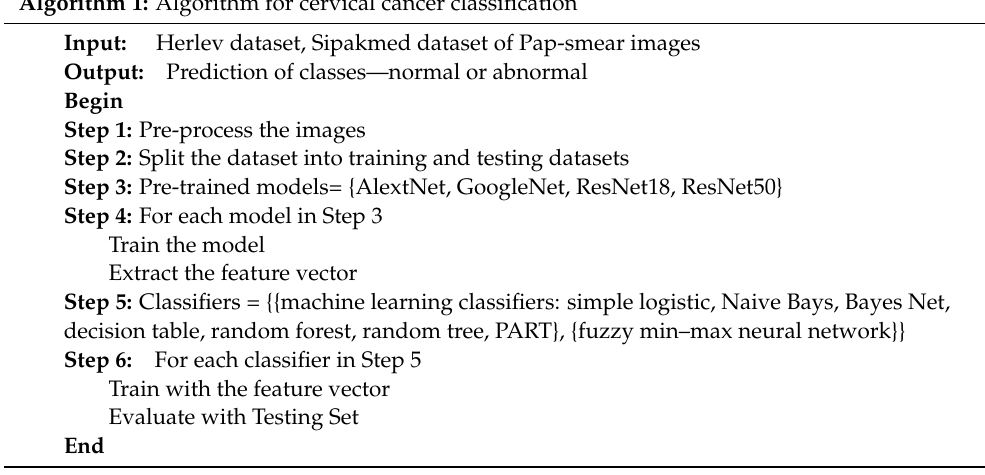
Algorithm 1: Algorithm for cervical cancer